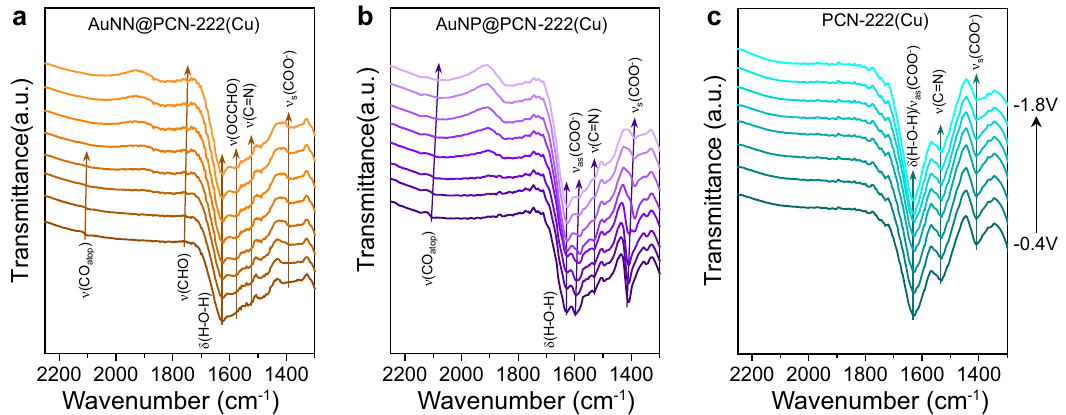
Fig. 6 Operando ATR-SEIRAS spectra. a AuNN@PCN-222(Cu), b AuNP@PCN-222(Cu), and c PCN-222(Cu). All spectra were recorded while ramping down the applied potential from − 0.4 to − 1.8 V to monitor the evolution of